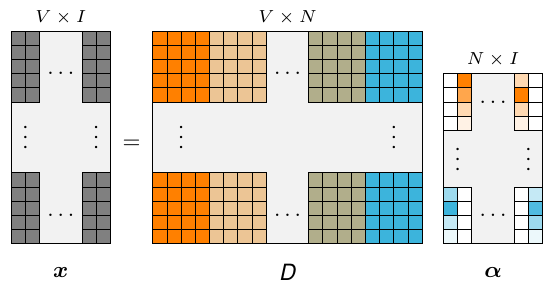
Figure 3: Schematic illustration of sparse representation. Differ- ent inclination groups in the dictionary are illustrated in different colors, whereas sparsity groups may contain multiple inclination groups. Color intensity indicate the value of the